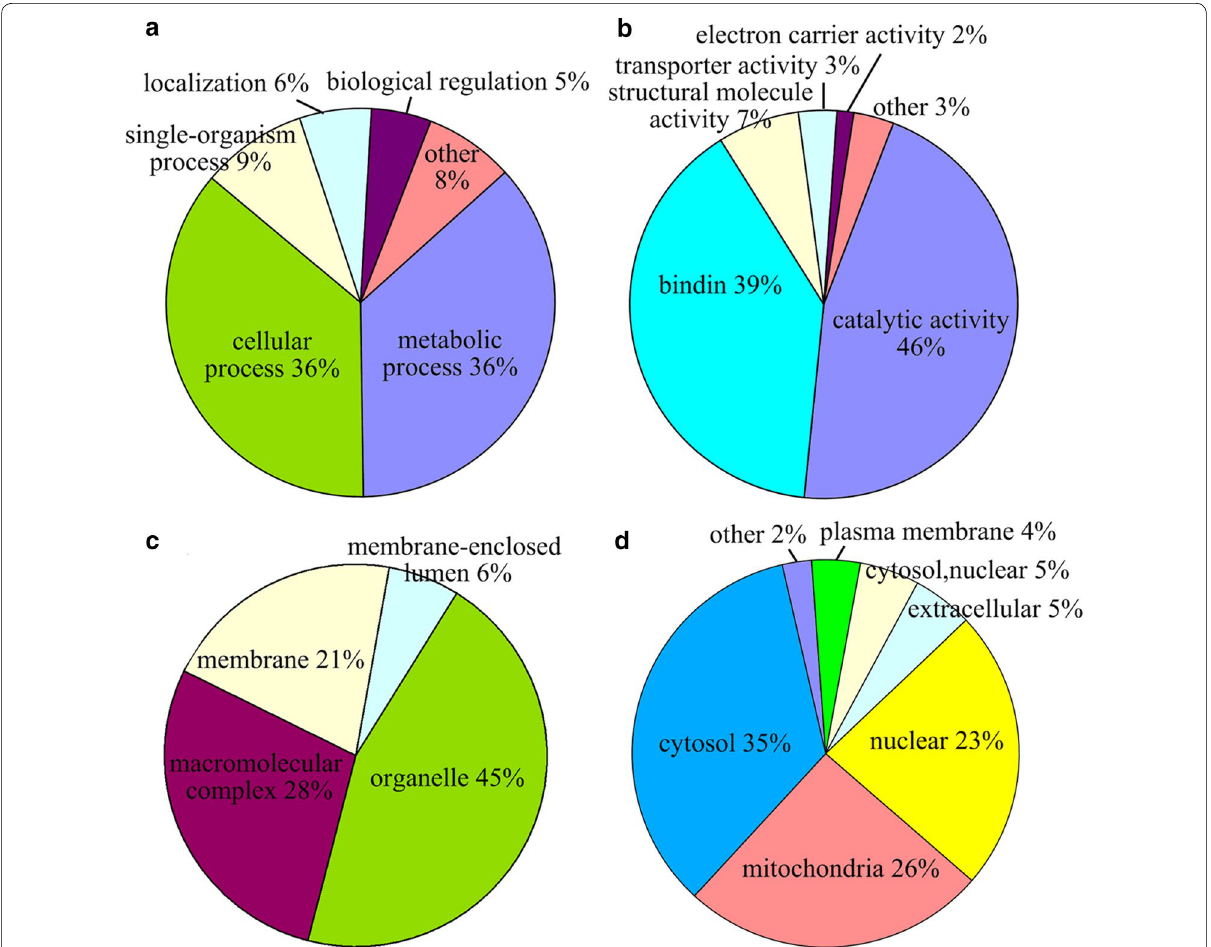
Fig. 6 Pie charts showing the functional classification of acetylated proteins in Y. lipolytica . a Classification of the acetylated proteins based on bio- logical process. b Classification of the acetylated proteins based on molecular function. c Classification of the acetylated proteins based on cellular component. d Subcellular localization of the acetylated